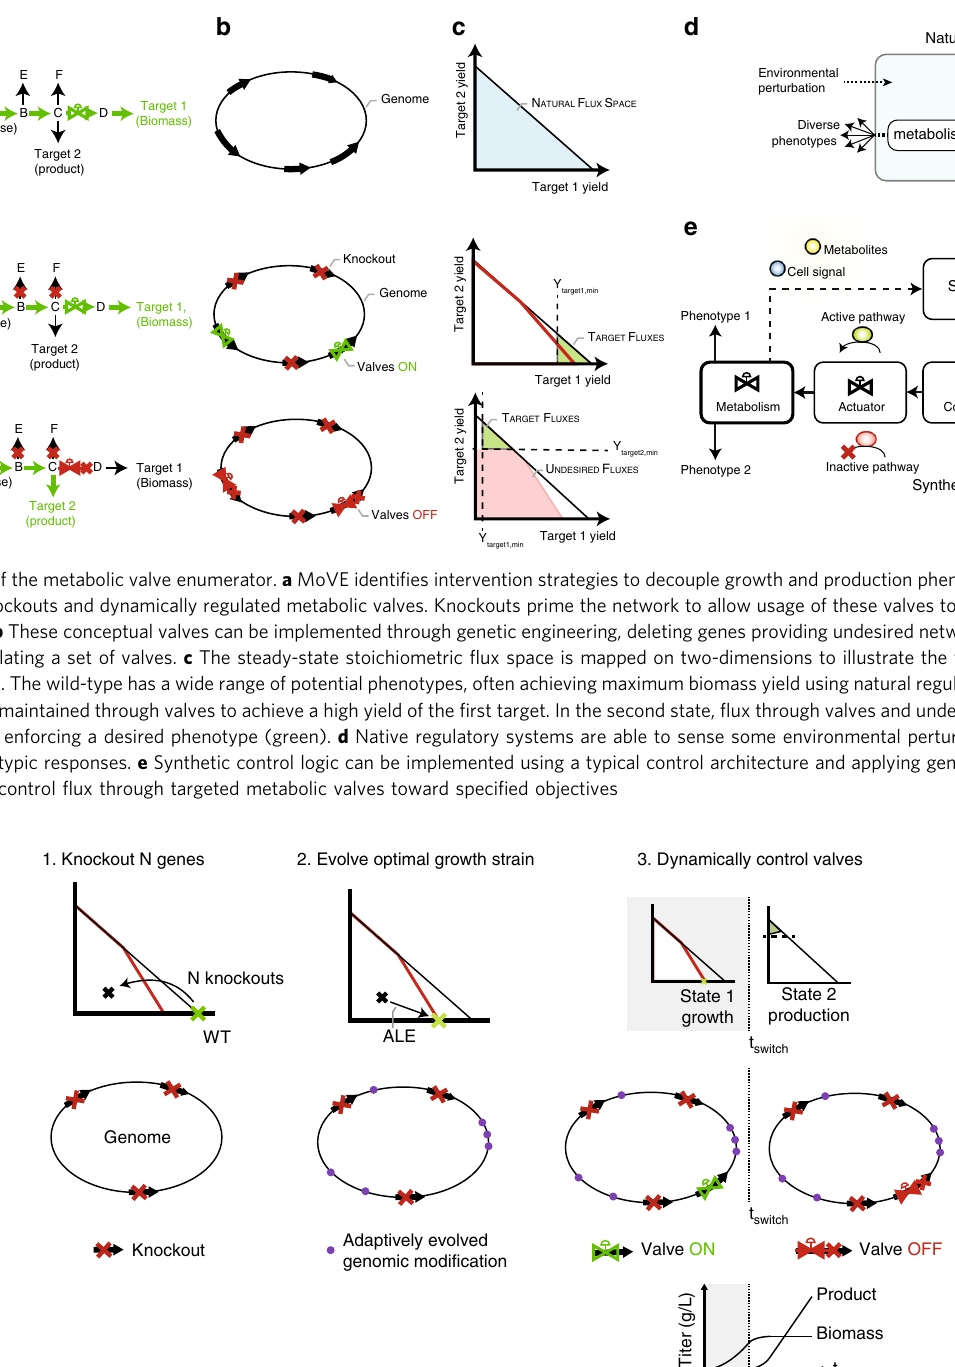
highly represented: glycolysis, the TCA cycle, and oxidative phosphorylation. The top fi ve valves included three from glycolysis: glyceraldehyde-3-phosphate dehydrogenase (GAPD, gapA ), pyruvate dehydrogenase (PDH, aceE ) and phosphogluco- mutase (PGM, pgm ); citrate synthase (CS, gltA ) from the TCA